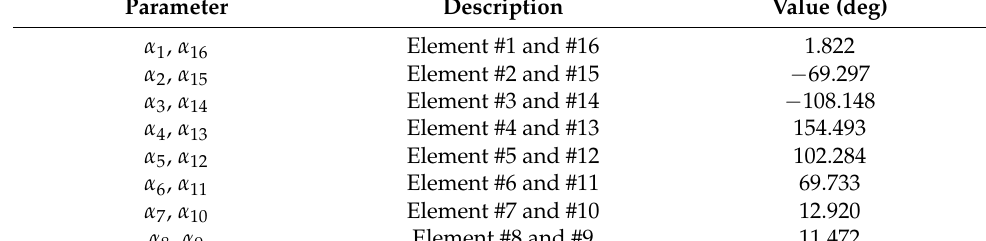
Table 3. Radiating Element Rotation Angles — Design 2.